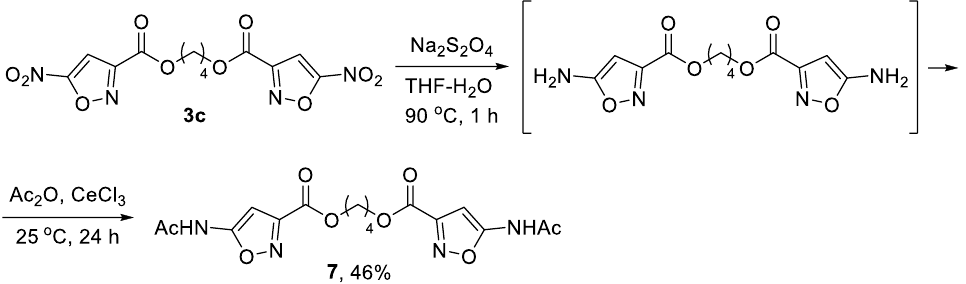
Table 2. The effect of various concentrations of compounds on the kainate-induced AMPA receptor currents in rat cere- bellum Purkinje cells. Com- pound Number of